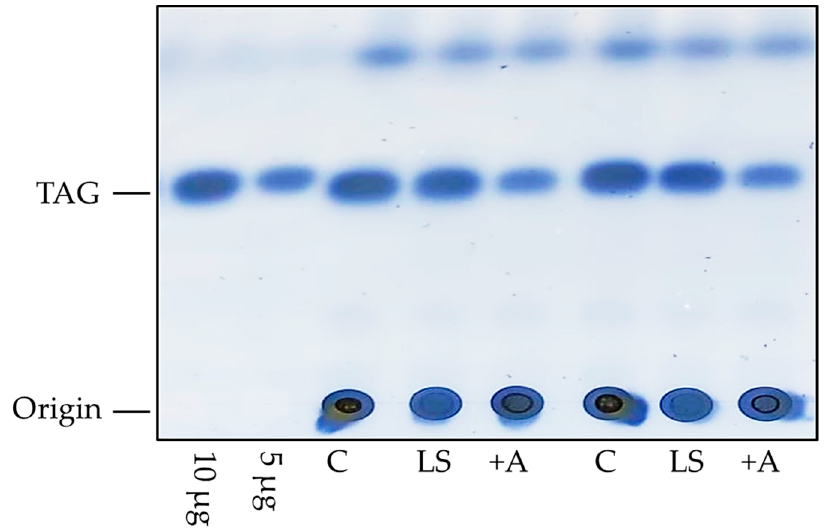
Figure 2. Example of triacylglyceride (TAG) determination in Drosophila melanogaster by thin-layer chromatography (TLC). Starting with eggs, fruit flies were raised on different experimental diets, and females were harvested 10 days after eclosion. TAGs were extracted from the flies, separated by TLC and stained according to the methods of Al-Anzi et al. (2009) [31]. A low-starch diet (LS) and acarbose treatment (+A) led to decreased TAG levels. C, control diet containing 10% starch; LS, low-sugar diet containing 1% starch; +A, control diet supplemented with 1.8 mg/L acarbose. Lard was used as a standard (the two bands on the